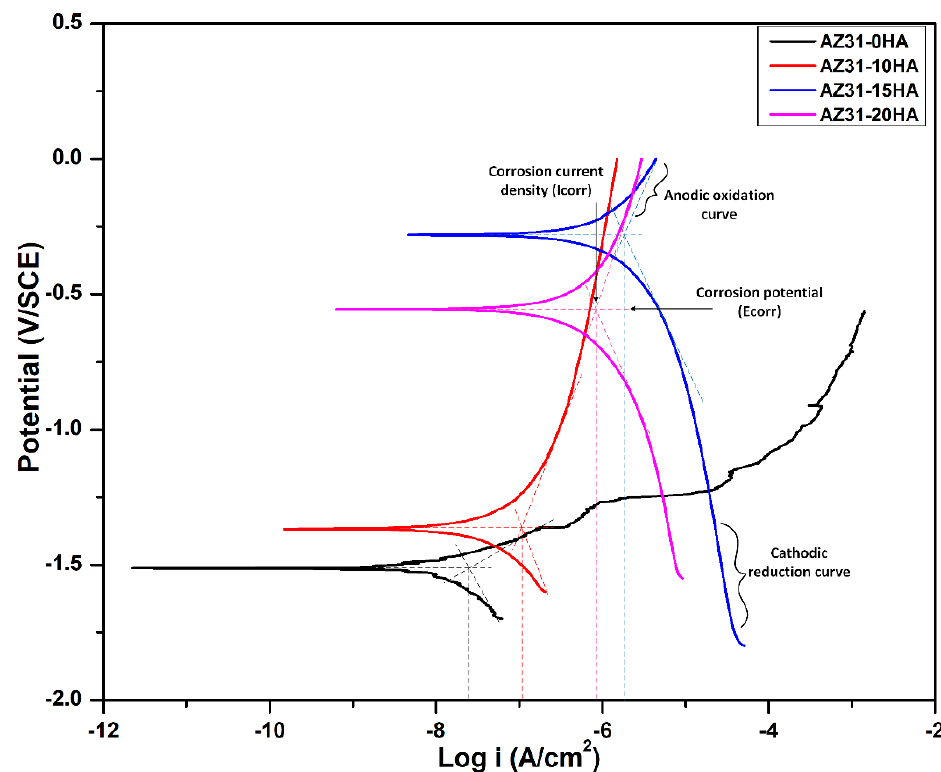
Figure 13. Electrochemical potentiodynamic curve of the BMMCs in HBSS at 37 ± 2 °C with SCE as a reference electrode. Table 4. Corrosion potential, corrosion current density and corrosion rate of BMMCs in HBSS.